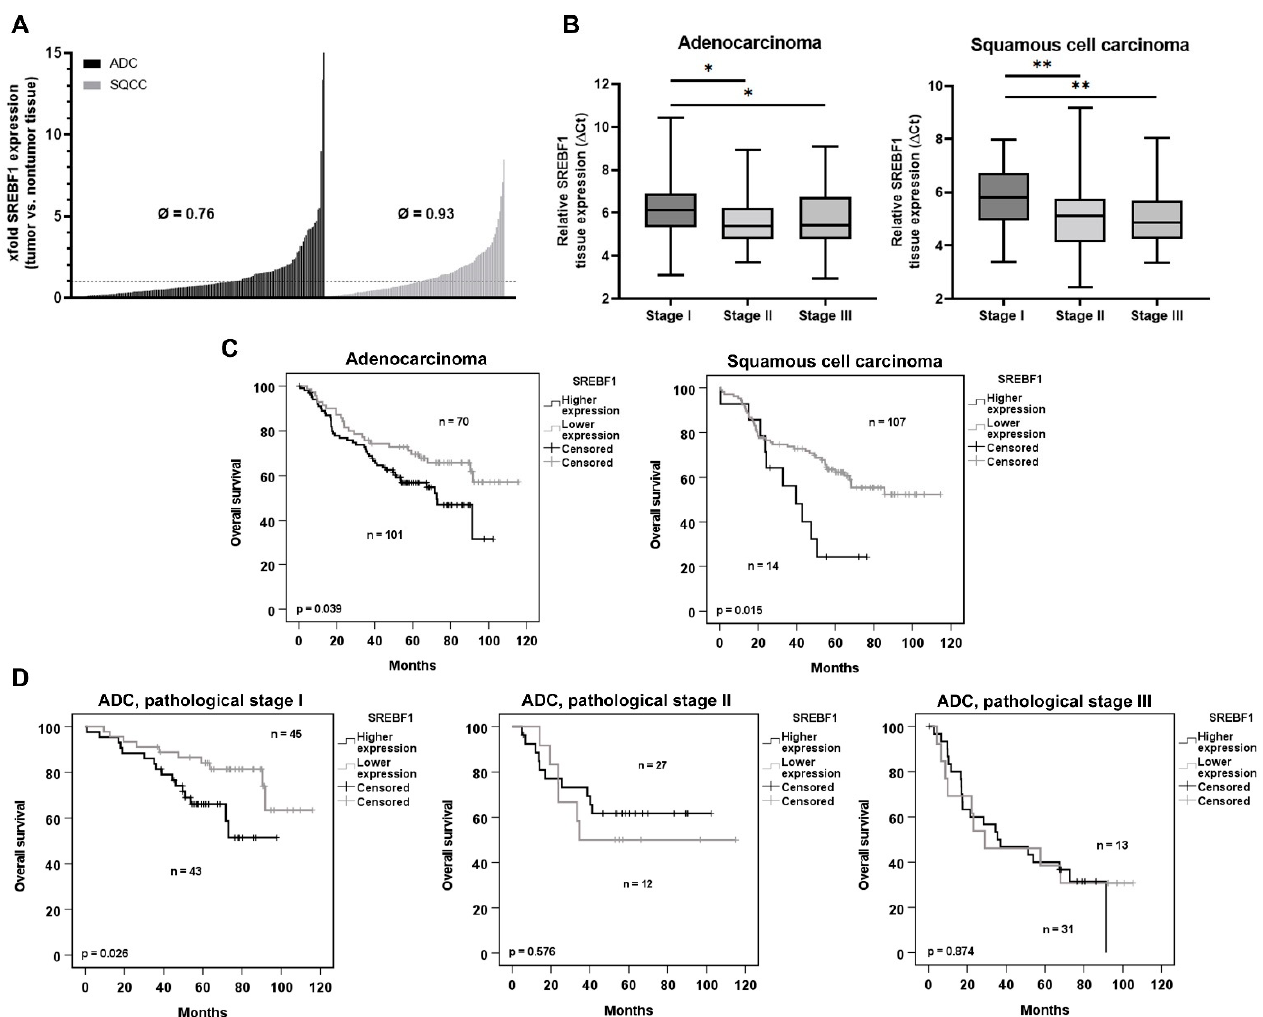
Figure 8. SREBF1 expression in NSCLC patients. ( A ) Fold change ( ∆∆ Ct) was calculated using relative gene expression of SREBF1 in tumor compared to normal tissue in 292 patients. ( B ) Relative SREBF1 expression in adenocarcinoma and squamous cell carcinoma. Gene expression was normalized with two housekeeping genes ( ESD and RPS18 ). Please note that higher values mean a lower gene expression. ( C , D ) Kaplan–Meier survival curves of SREBF1 tumor expression. Cutoffs for the separation of the groups in ( C ), ( D ) were calculated using the R tool Cutoff Finder [29]. ADC = adenocarcinoma, SQCC = squamous cell carcinoma, Ø = median, * p < 0.05, ** p < 0.005.